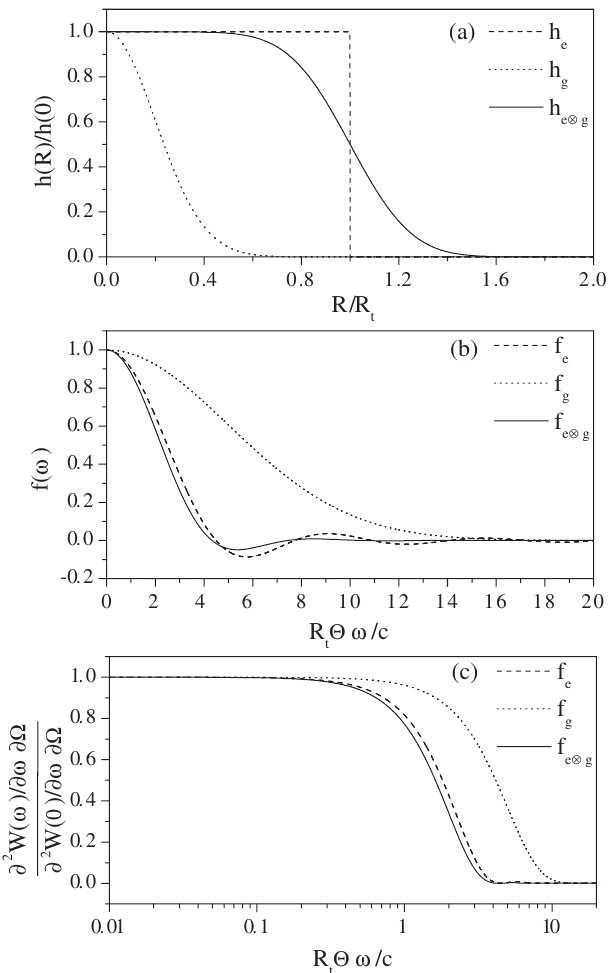
FIG. 2. Plot of the three different electron distributions (a), form factors (b), and power spectra (c) belonging to the different electron bunches discussed in this paper; the ellipsoidal electron and f ), the Gaussian electron bunch bunch with hard edges ( h e e and f ), and the ellipsoidal electron bunch with soft edges ( h g g (cid:5) 0 : 2 R ( h and f ). In all plots (cid:8) e (cid:15) g e (cid:15) g t t